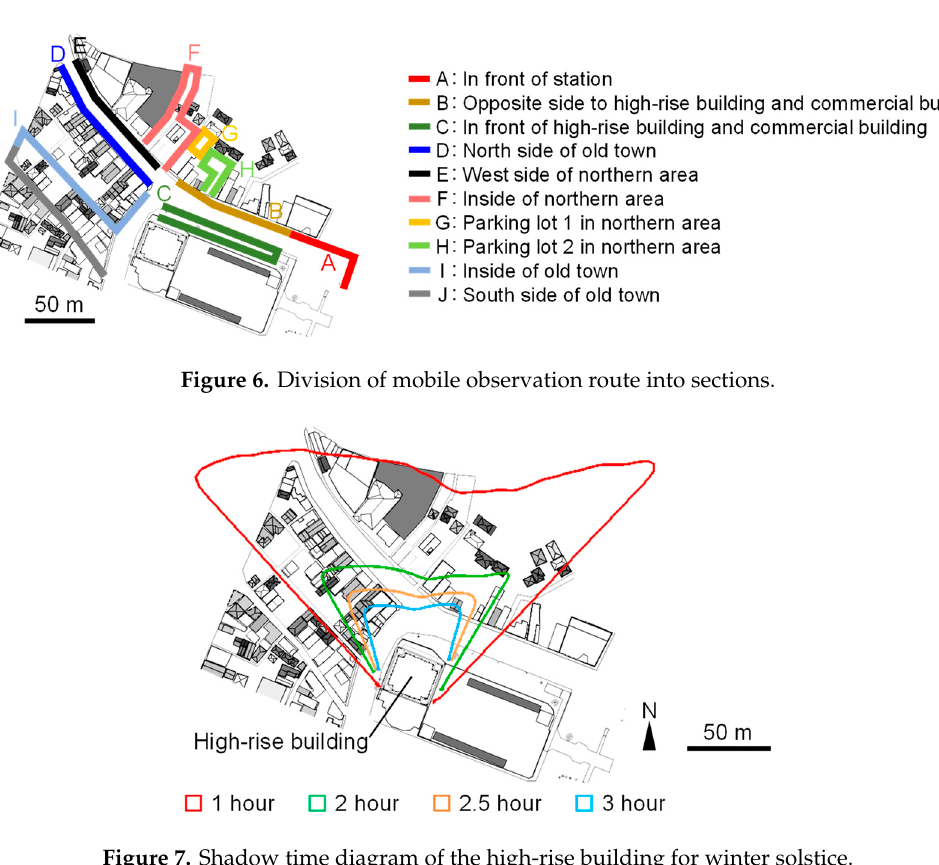
Figure 8. 3-D CAD model of the target spaces.